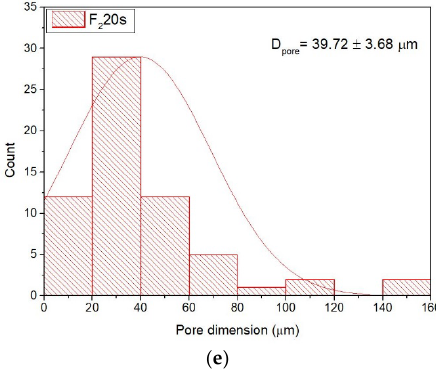
Figure 5. SEM images magnification ×200 and ×20,000 of F 2 ( a , b ) and F 2 20s ( c , d ) samples and pore dimension distribution ( e ); the pores are indicated with yellow arrows.